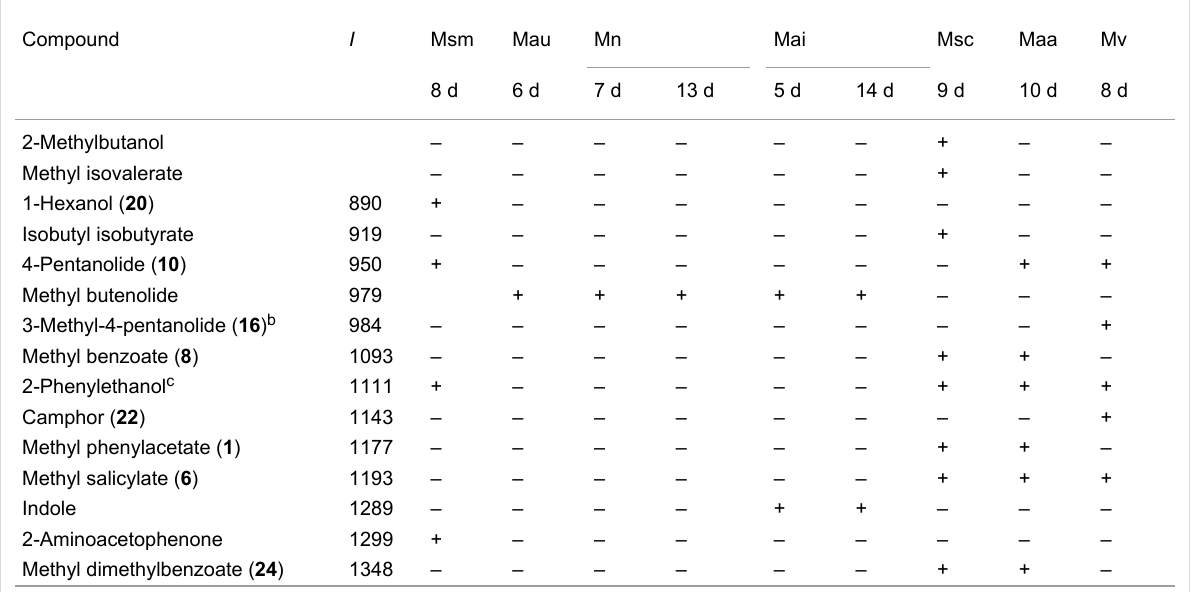
Table 5: Volatiles released by diverse nontuberculous mycobacteria grown in the 7H9 broth medium. a